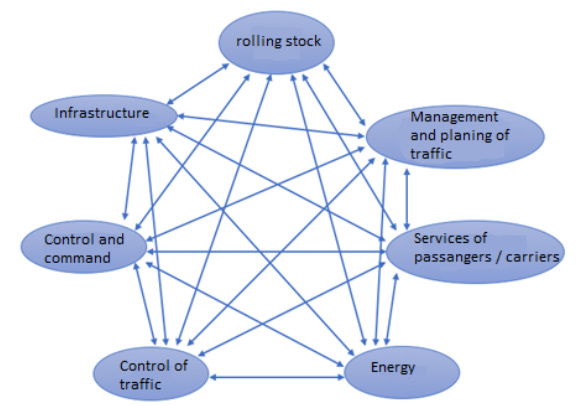
Figure 2. Conceptual vision of